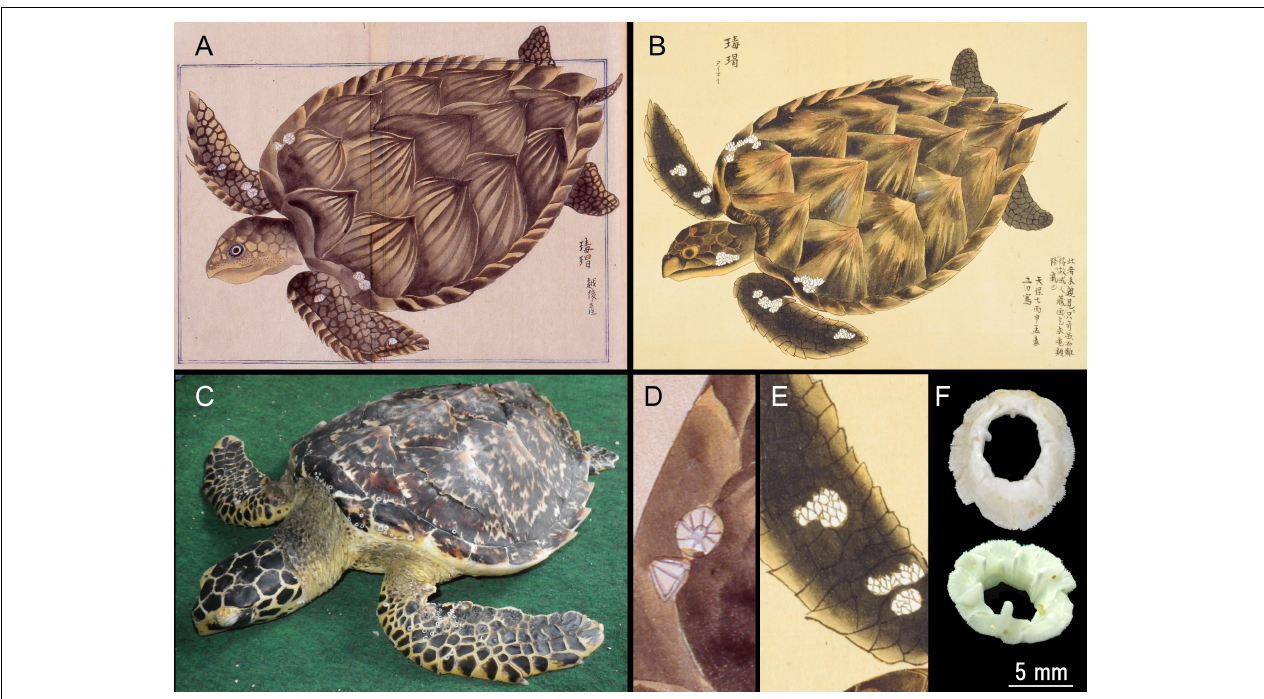
FIGURE 1 | (A,D) Hawksbill turtle with barnacles illustrated by Shunzan Takagi; (B,E) Copied illustration by Baien Mouri; (C,F) An encrusted living hawksbill turtle and Platylepas hexastylos .